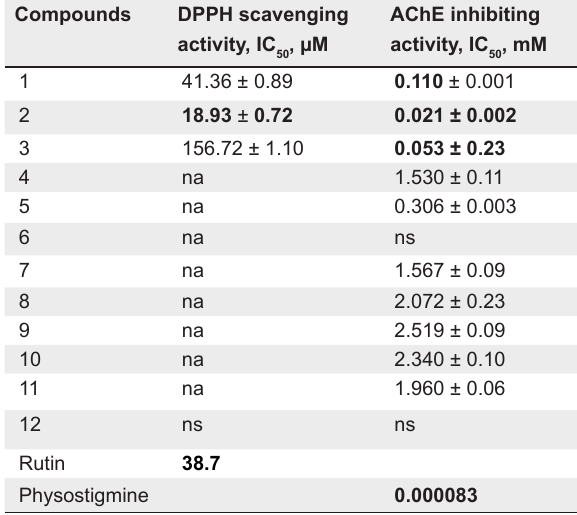
Table 3. Anti-oxidative and AChE inhibitory activities of isolated